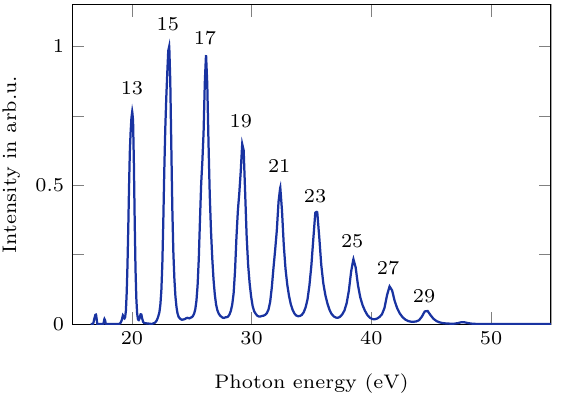
Figure 5. XUV spectrum recorded by the XUV spectrometer. The spectrum contains photons from harmonic order 13 (20.0 eV) up to harmonic order 29 (44.7 eV), indicated above the